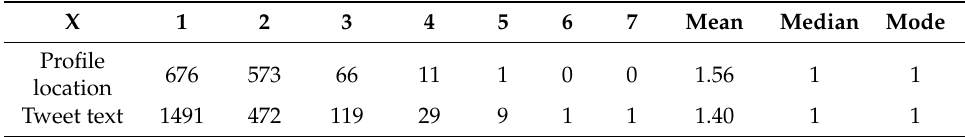
Table 4. Frequency of tweet documents with X number of place names in the profile location and tweet text.